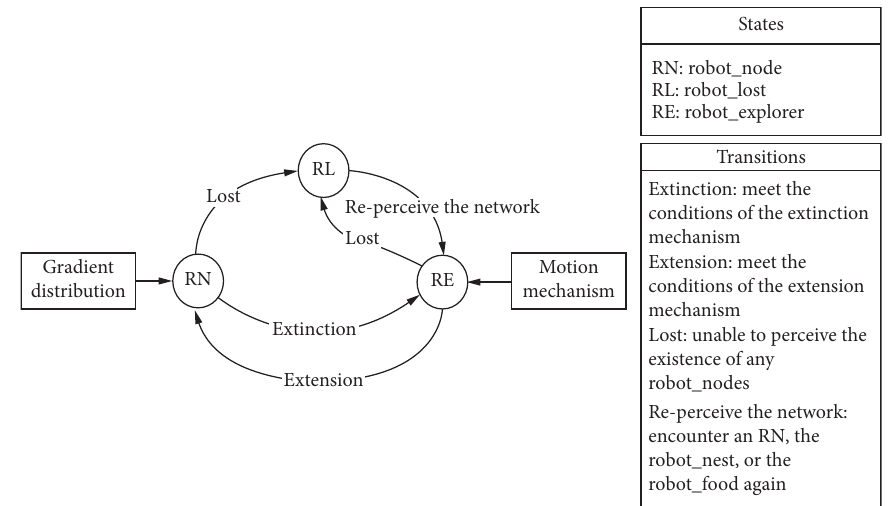
Figure 8: The probabilistic finite state machine (PFSM) of the individual robot